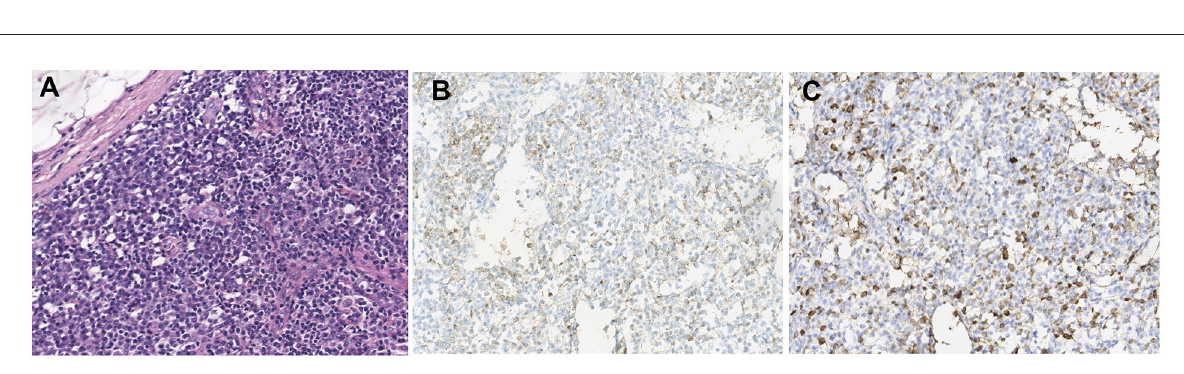
FIGURE4 Histological examination of the biopsy of inguinal lymph node (A) H&E staining; (B) immunohistochemistry for CD138; (C) immunohistochemistry for IgG4; 200 × ).